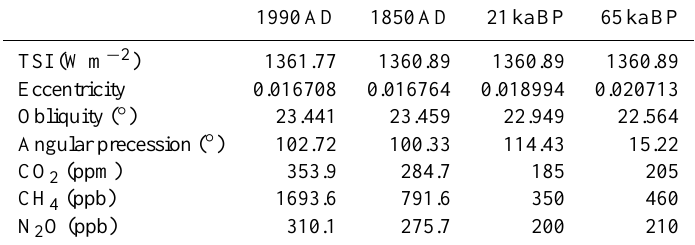
Table 2. External forcing level for the four periods investigated in this study. The orbital parameters are calculated according to Berger (1978). Glacial levels of CO 2 , CH 4 and N 2 O are estimated from ice cores according to Schilt et al. (2010) and B. Bereiter (personal communication, 2012) for MW and following the PMIP protocol for LGM (http://www-lsce.cea.fr/pmip2/). Note that the external forcing indicated in the table correspond to the values in the CCSM4 simulations and that they may slightly differ in the CCSM3 simulations, e.g., for 1850AD the forcing in the CCSM3 simulation corresponds to